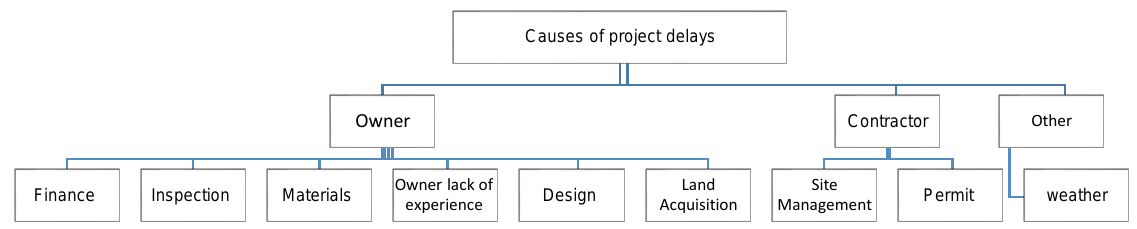
Fig. 2. Classificationon factors of delay causes in pipeline